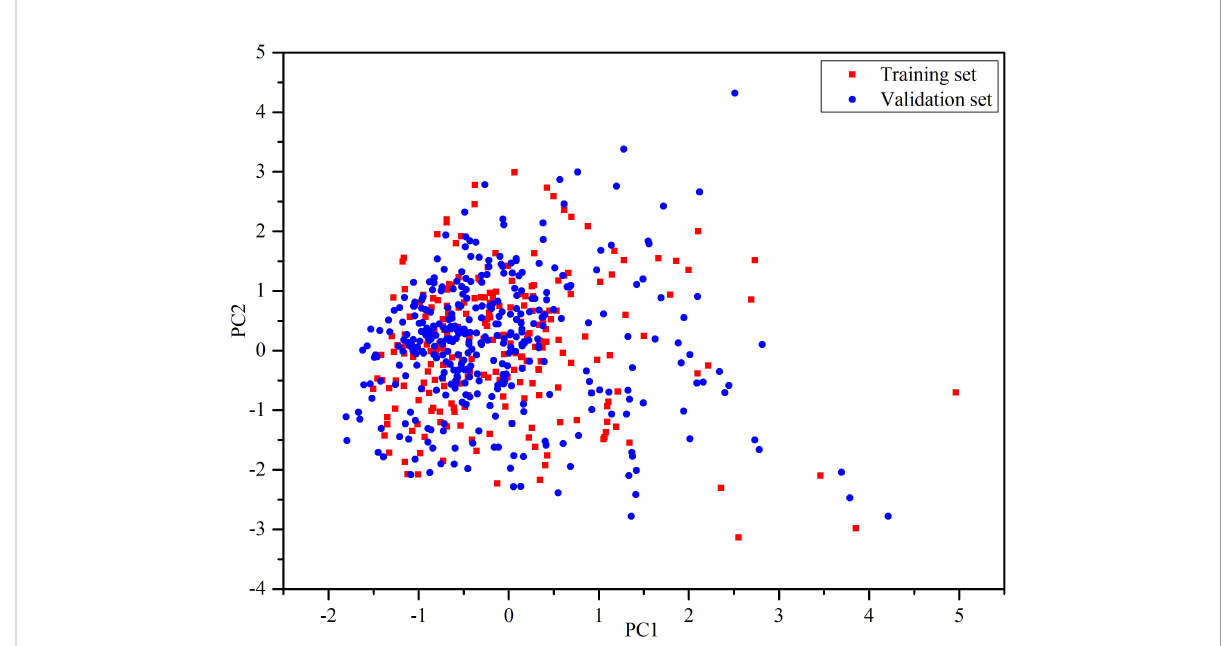
FIGURE 1 Chemical space de fi ned by the fi rst two principal components of physical-chemical descriptors. Red squares stand for the training set, blue circles stand for the validation